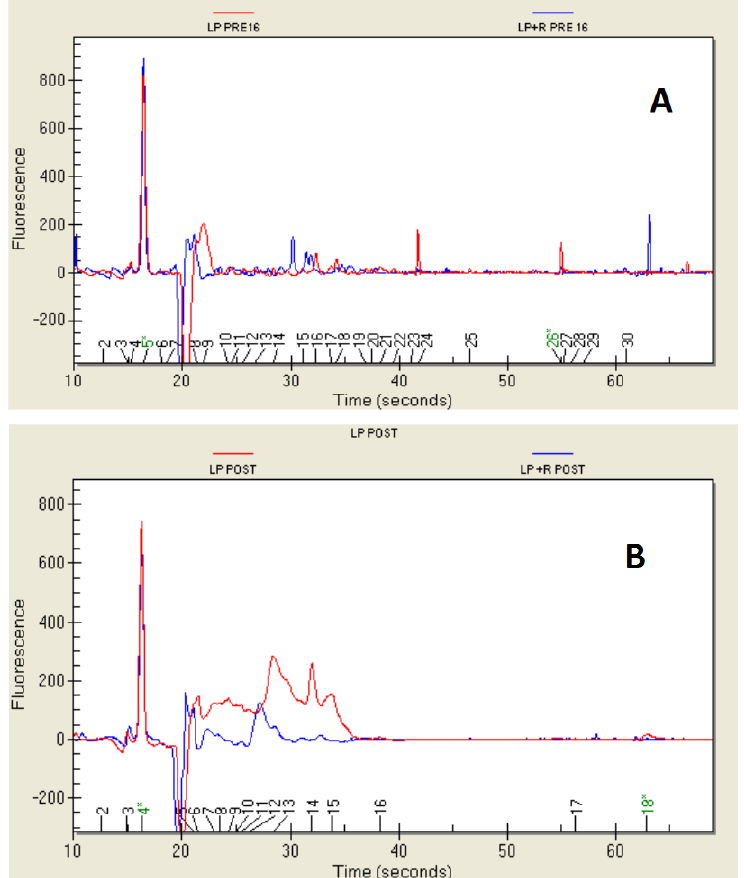
Figure 2. Protein profile (shown as an electropherogram) of Lactobacillus plantarum , grown in MRS and MRS + E. sativa , before (LP PRE and LP + R PRE) ( A ) and after (LP POST and LP + R POST) ( B ) the in vitro gastro-intestinal